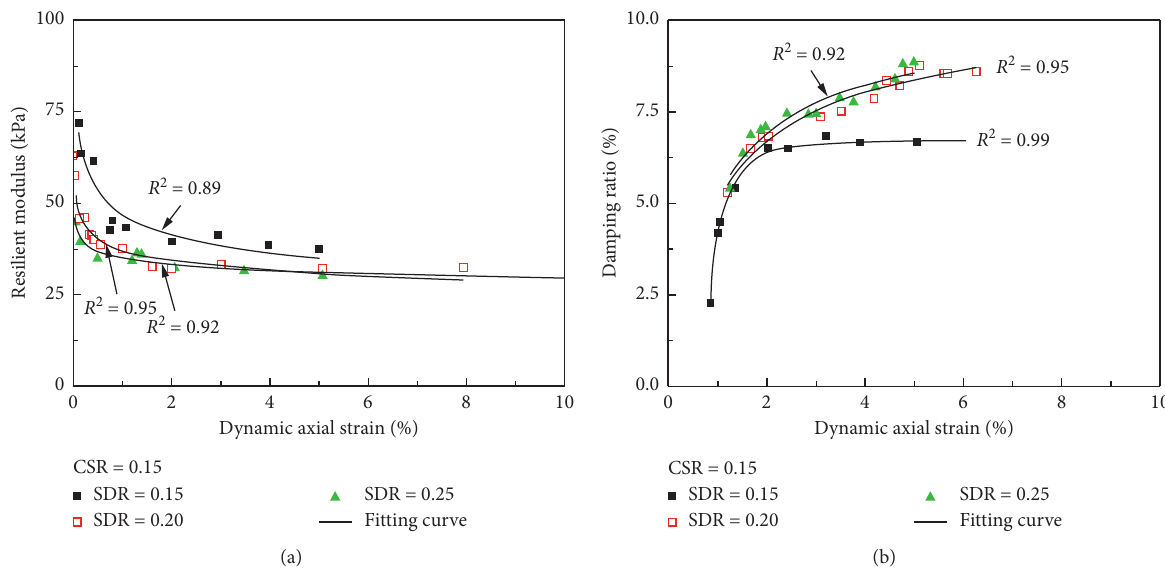
Figure 6: Variations of dynamic parameters with dynamic axial strain at different SDR: (a) M